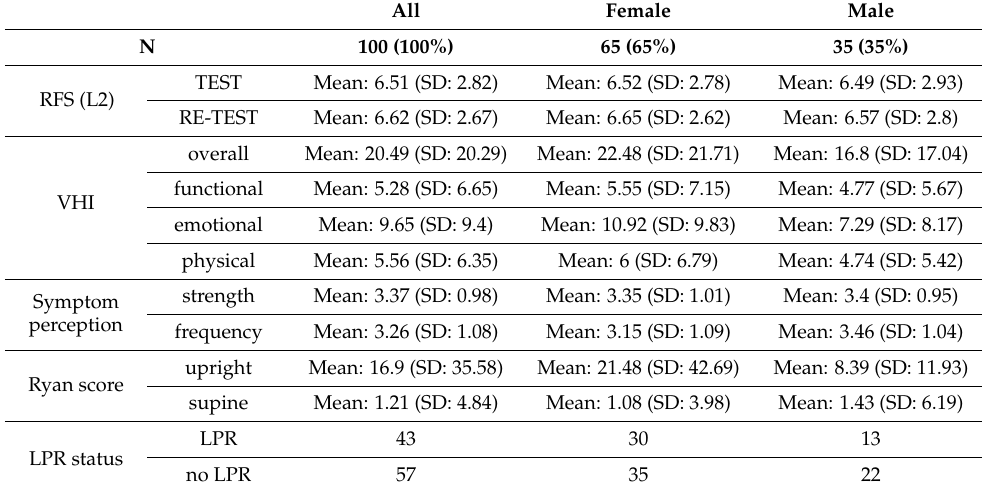
Table 4. Baseline statistics of the main study group.